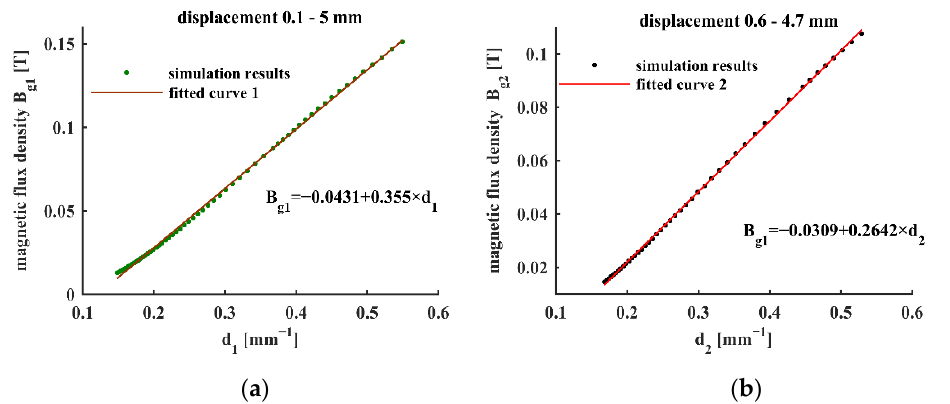
Figure 3. Linear fitting curves of magnetic flux density with d : d 1 = ( l + 1.72) − 1 and d 2 = ( l + 1.27) − 1 where l represents the displacement: ( a ) displacement range 0.1–5.0 mm ( b ) displacement range 0.6–4.7 mm.